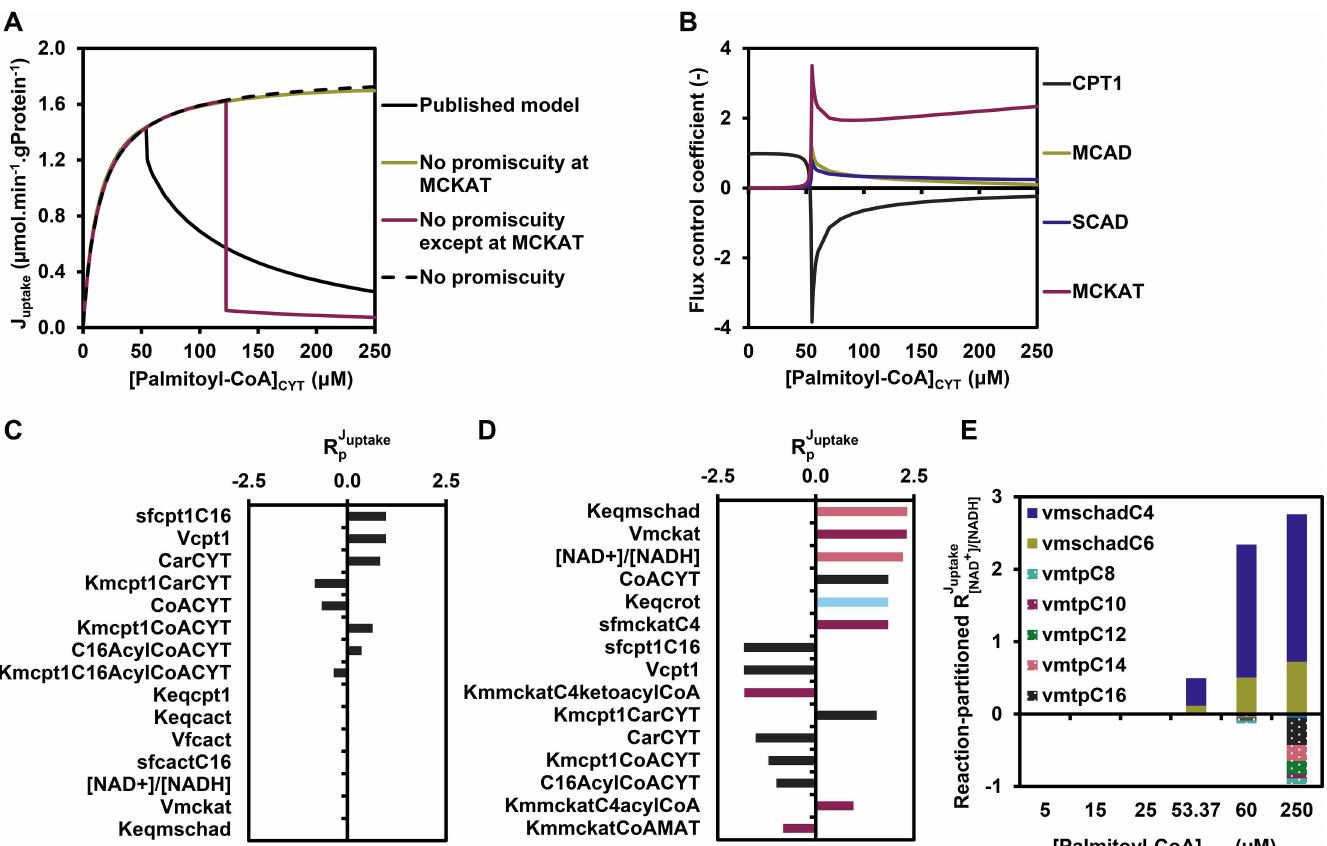
Fig 3. The role of the short-chain branch. (A) Steady-state flux versus [palmitoyl-CoA] CYT in the published model (black line), a model without any enzymatic promiscuity (black dashed line, reproducing results from [8] as a reference), a model without promiscuityof MCKAT (green line), and finally a model with only promiscuity of MCKAT, but not of any of the other enzymes (purpleline). (B) The flux control coefficients in the originalmodel as a function of [palmitoyl-CoA] CYT . Only enzymes with a substantialcontribution are included; for a completeset of flux control coefficients, see figure A in S2 Fig. (C-D) Top 15 flux response coefficients with the highest absolutevalues at 25 μ M (C) and 60 μ M (D) of [palmitoyl-CoA] CYT . The parameters p for which the flux responsecoefficient was calculatedis indicatedon the Y-axis. Dark grey bars represent CPT1-related parameters, pink bars representM/SCHAD-related parameters, purplebars represent MCKAT-related parameters and the light blue bar represents a crotonase-related parameter. (E) Flux response coefficient of [NAD + ]/[NADH] ( R Juptake ) partitioned in contributionsof individualNAD + -dependentreactions at 5 palmitoyl-CoA concentrations ½ NAD þ (cid:138) = ½ NADH (cid:138) P ¼ (cid:1) ε v i C J accordingto R J . (cf. Eq 4). The contributionsof M/SCHAD reactionsC8-C16to R Juptake ½ NAD þ (cid:138) = ½ NADH (cid:138) ½ NAD þ (cid:138) = ½ NADH (cid:138) i i not shown in the legend.